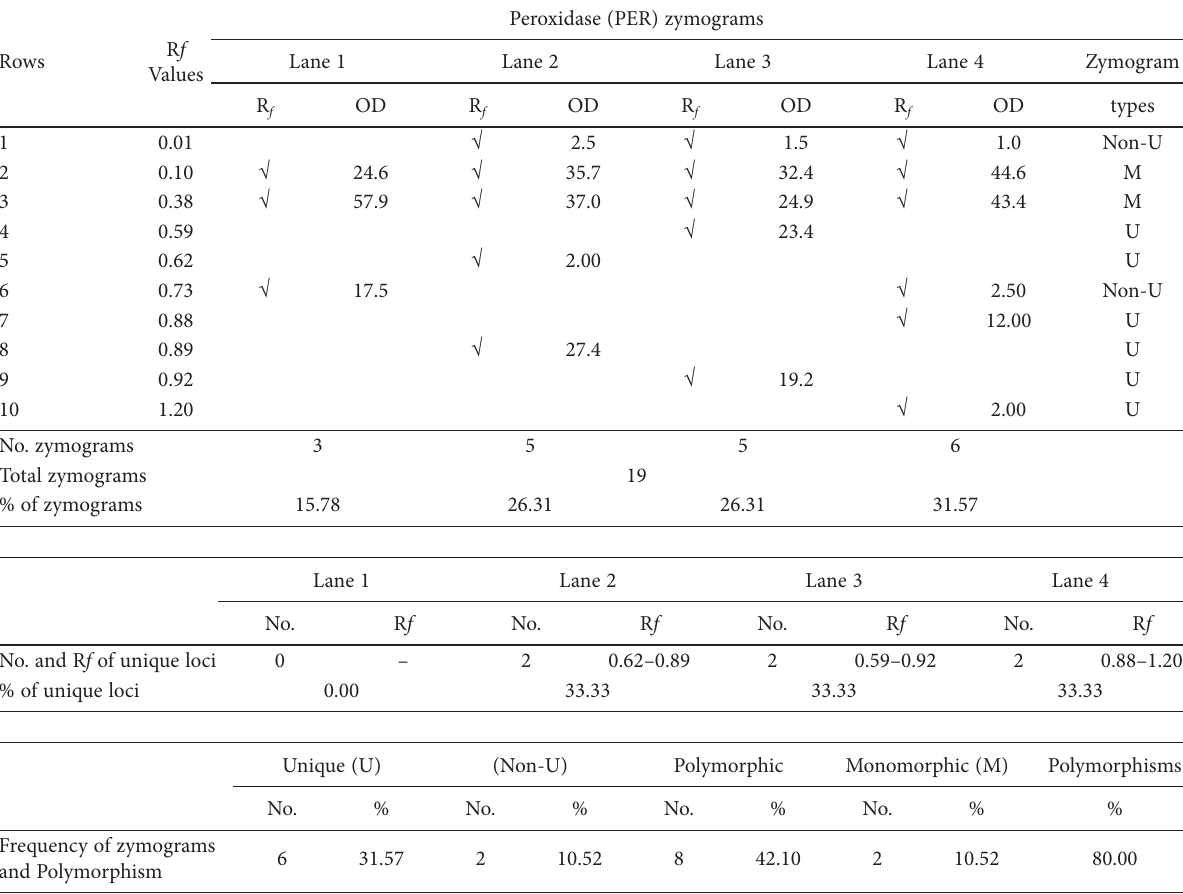
Table 4. Distribution of peroxidase (PEX) zymograms of EMF non-exposed and exposed Zea mays seedlings for days of exposure times (Ex-0, Ex-1, Ex-3, and Ex-5) based on relative front (R f ) Values and optical densities (OD). Lanes 1–4 represented the days of exposure times (Ex-0, Ex-1, Ex-3, and Ex-5),